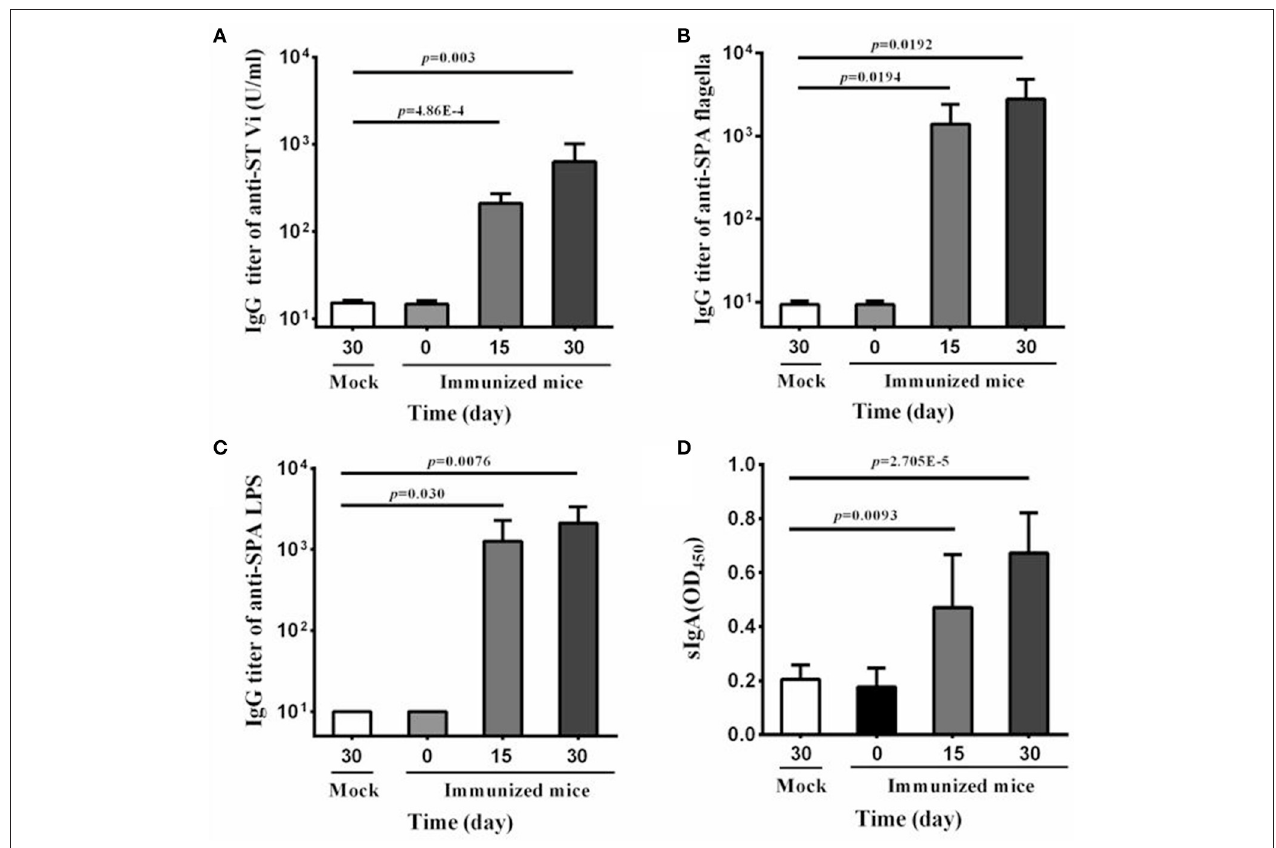
FIGURE 5 | Serum and mucosal antibody responses to intranasal immunization with SPA-VPH. BALB/c mice were nasally administered with SPA-VPH at 2.0 × 10 9 CFU/mouse. At indicated time points, samples of sera and intestinal contents were harvested. IgG and IgA levels were determined by ELISA. (A) Levels of IgG against the Vi of Salmonella enterica serovar Typhi in the mouse sera. (B) Levels of IgG against the flagellin of Salmonella enterica serovar Paratyphi A in the mouse sera. (C) Levels of IgG against the LPS of S. Paratyphi A in the mouse sera. (D) Levels of total sIgA against the cell lysate of S. Paratyphi A in the intestinal contents of the